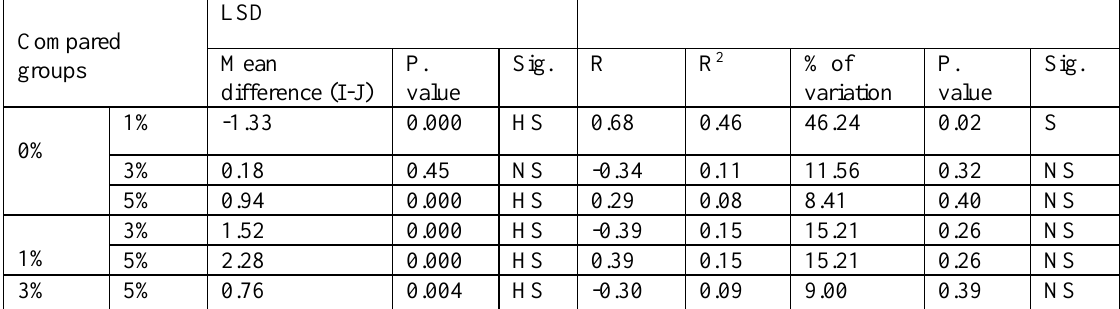
Table (4): Post-hoc LSD, Pearson correlation (R), Coefficient of determination (R 2 ) and % of variation for tensile strength